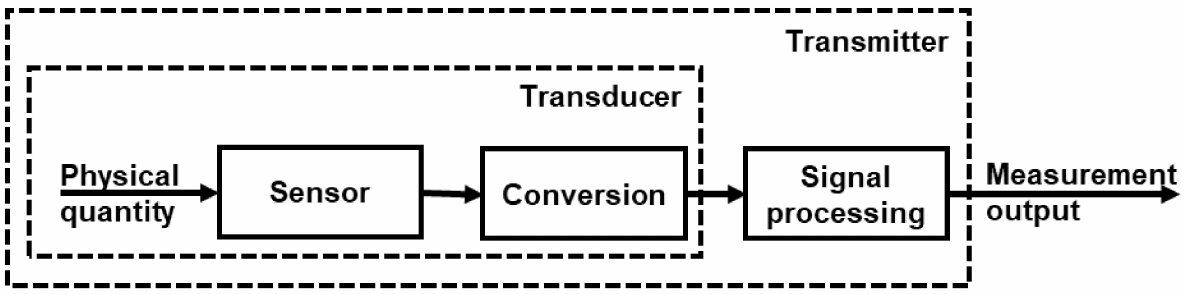
Figure 2. Measurement chain from sensor to measurement